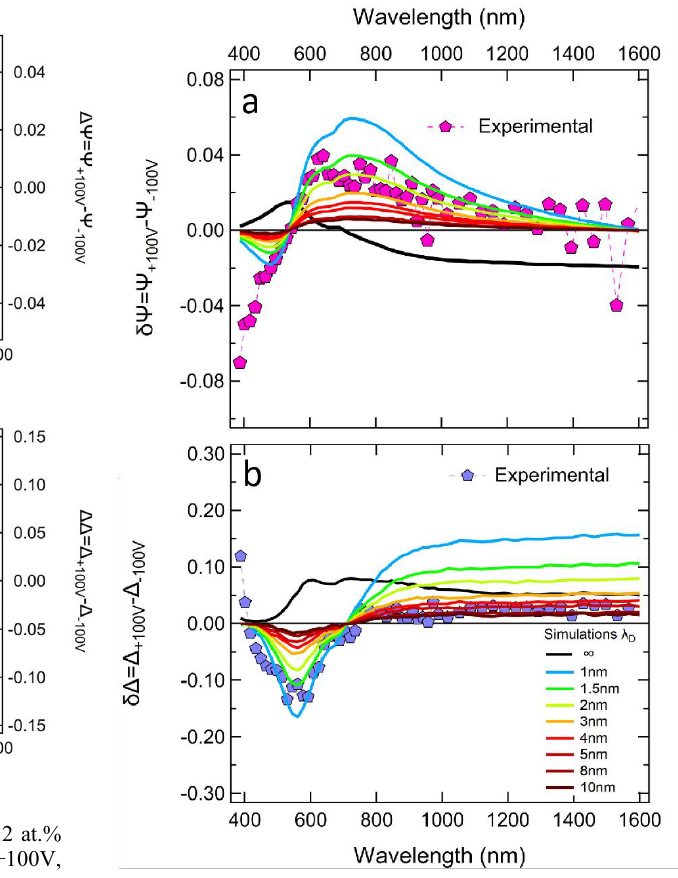
Fig. 2. a (b): Magenta (indigo) symbols: experimental difference spectra δΨ (δΔ)) as a function of wavelength, at T=4.2 K. Solid lines: calculated difference spectra obtained by modelling the charge injection/depletion in the AZO film. Different colours represent different values of the Debye length in the AZO